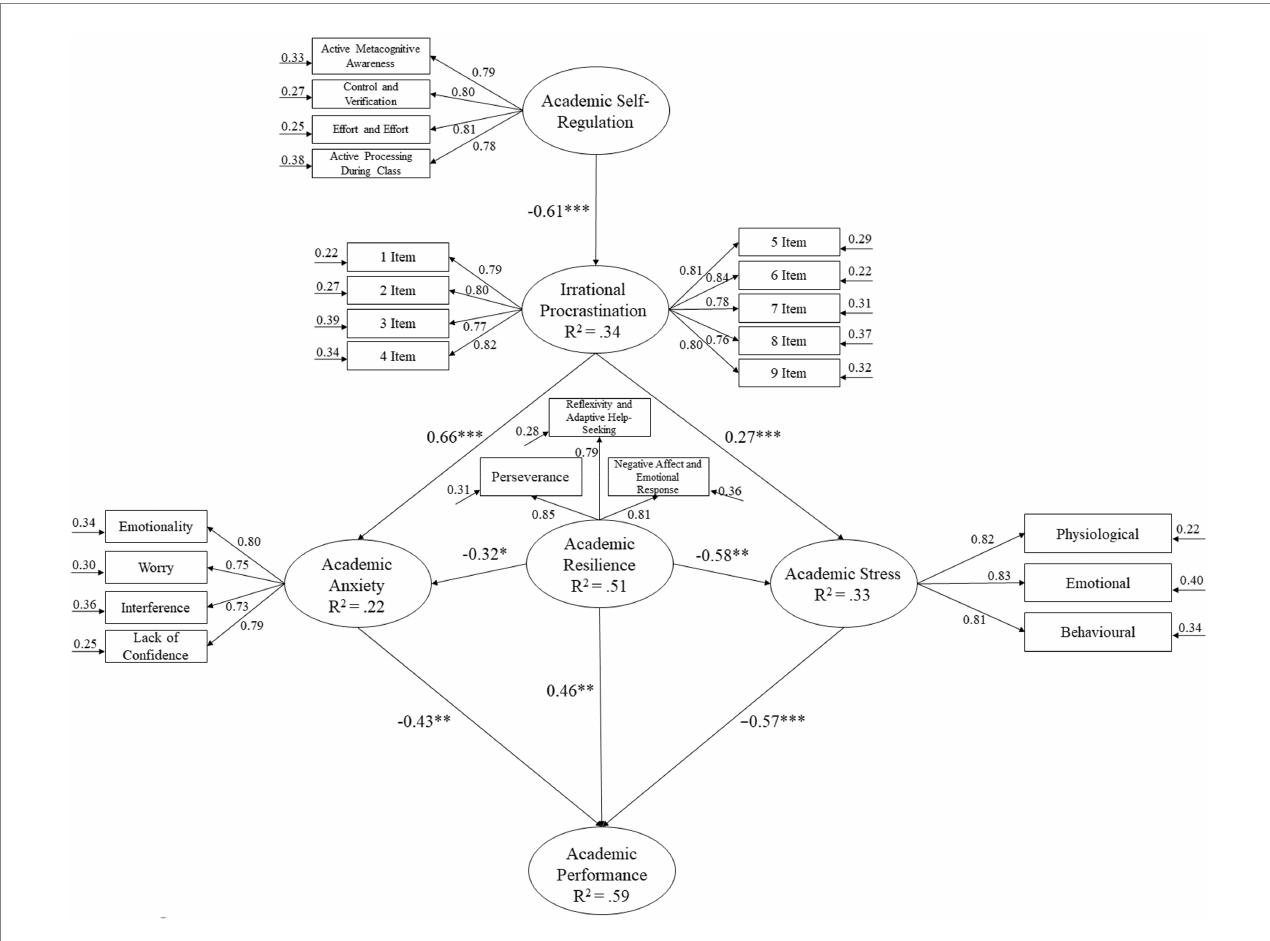
FIGURE 1 Structural equation model showing the relationships between variables. * p < 0.05; ** p < 0.01; *** p <